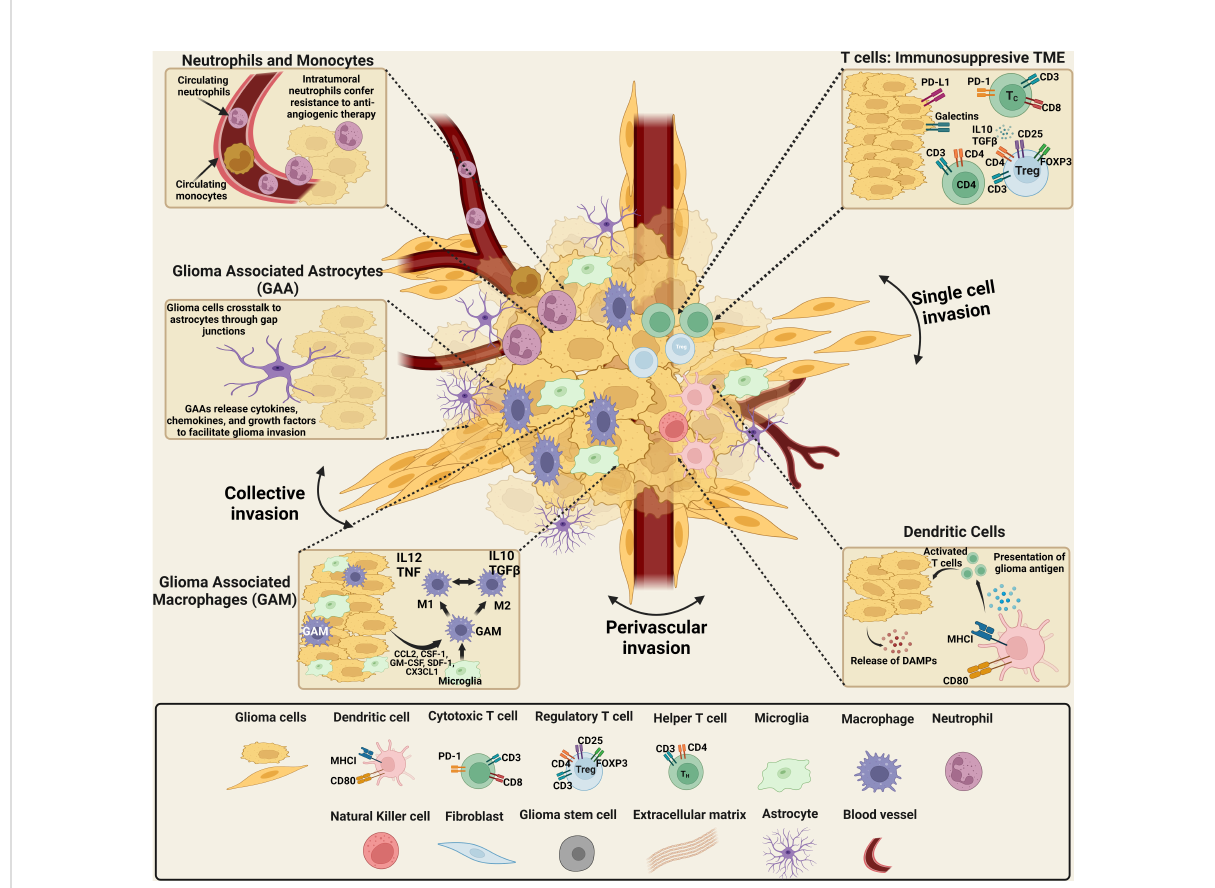
FIGURE 1 Schematics of the cellular components of the brain tumor microenvironmental landscape. The cellular components of gliomas: malignant and non-malignant cells, including tumor cells, a range of invasive peripheral immune cells, cells from the healthy brain including neurons and neuroglia, as well as pericytes and endothelial cells. The non-malignant cellular component consists of local immune cell types, including microglia and astrocytes, as well as lymphocytes, endothelial cells. High numbers of neutrophils in the systemic circulation indicates a positive therapeutic response. However, the presence of neutrophils in the glioma microenvironment confers resistance to anti-angiogenic therapy, suggesting high-grade glioma. Neutrophils promote the proliferation of GSCs with mesenchymal phenotypes and GSCs recruited through TGF- b secretion induce an immunosuppressive and, protumoral, M2 phenotype in macrophages. TGF- b and IL-10, immunosuppressive cytokines that impair T-cell response and antigen-presenting cell function, are overexpressed by glioma cells. The expression of MHC-I is downregulated in glioma cells while PD-L1 is upregulated, impairing T-cell response. Additionally, CTLA-4 expression reduces TCR activity. Recruitment and development of regulatory T cells are stimulated by TGF- and IL-10. Finally, the release of GM-CSF and CSF-1 by glioma cells promotes the recruitment of macrophages and polarization of M1 macrophages to an M2-like phenotype. The tumor – brain interface is distinguished by an invasive edge that harbors invasive glioma cells that migrate via white matter tracts or extracellular matrix fi bers to in fi ltrate the brain parenchyma either collectively or as a single cell invasion. Glioma cells have been demonstrated to invade the perivascular space collectively, as a conduit for invasion. [Created with